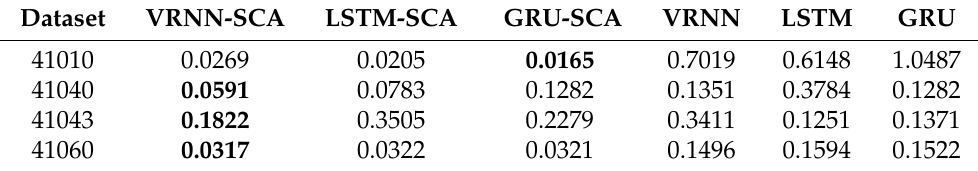
Table 12. Comparison in terms of average root mean square error (RMSE) on all dataset. Dataset